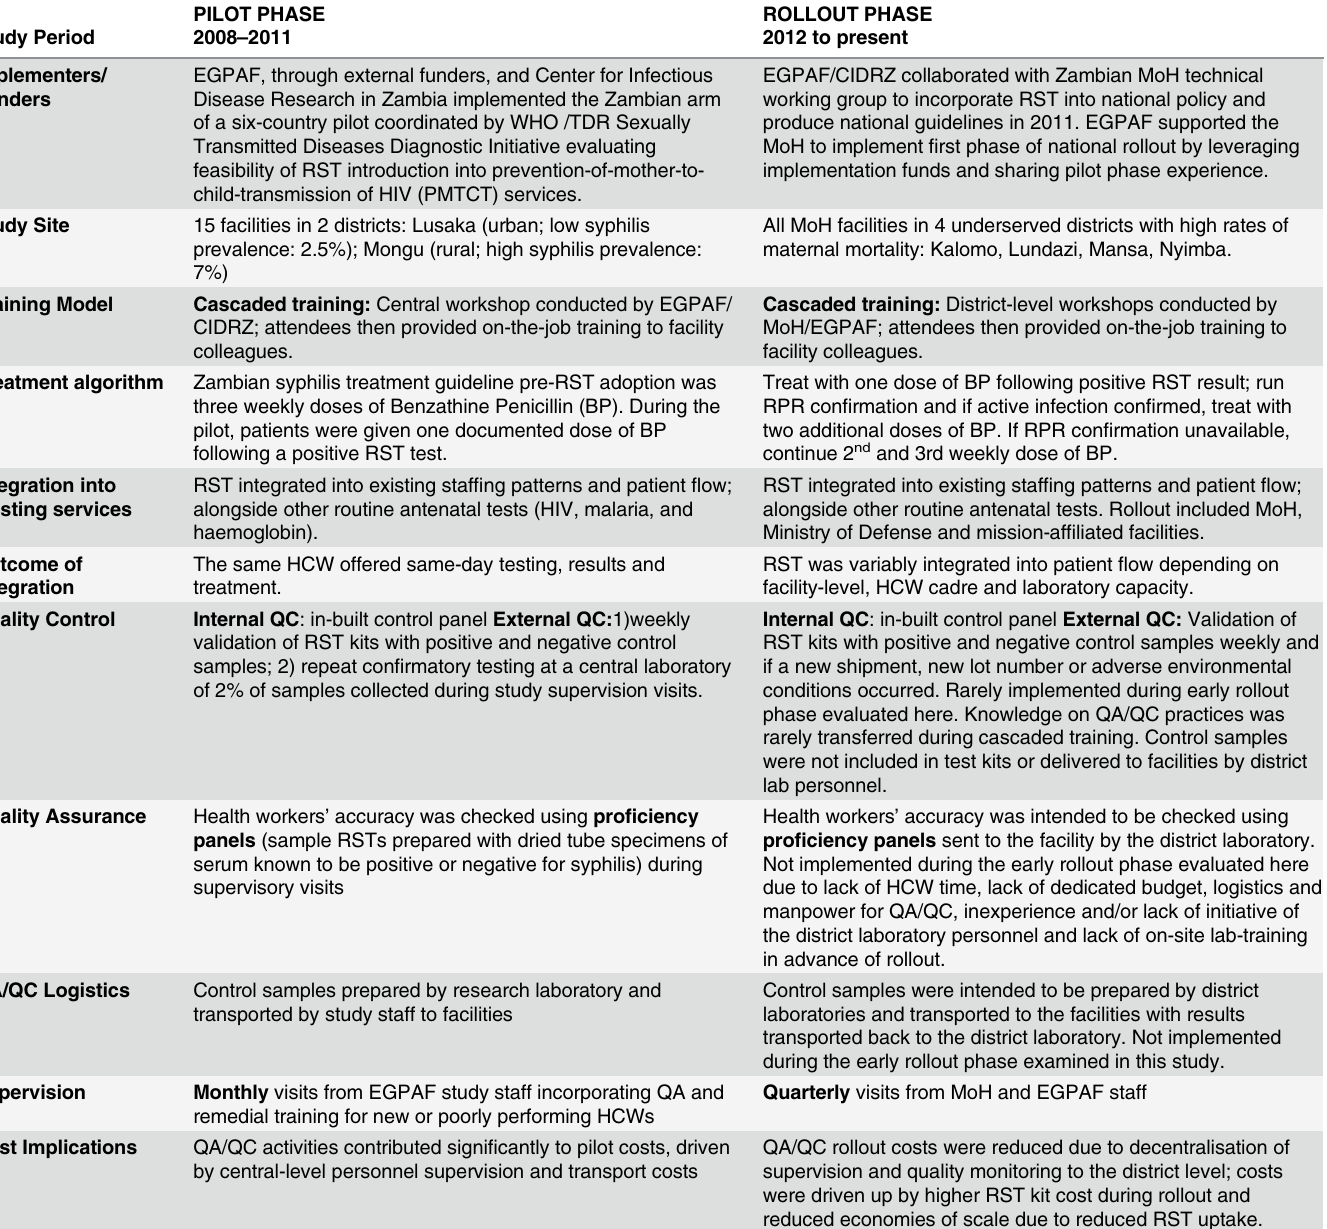
Table 1. Changes in implementation methods from NGO-led RST pilot to MoH-led national RST rollout in Zambia 2008 –